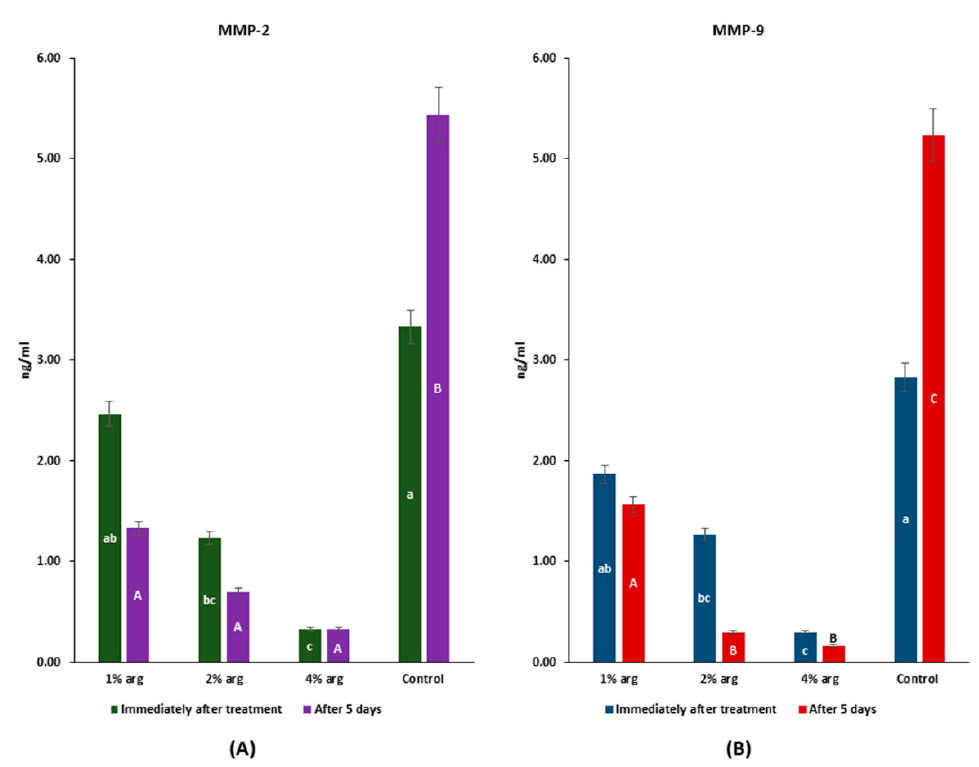
Figure 4. MMP assay to determine the interactions of arg with ( A ) MMP-2; and ( B ) MMP-9. The lowercase (a–c) and uppercase (A–C) letters identify significant differences between the experimental groups, immediately after the treatment and after 5 days, respectively.